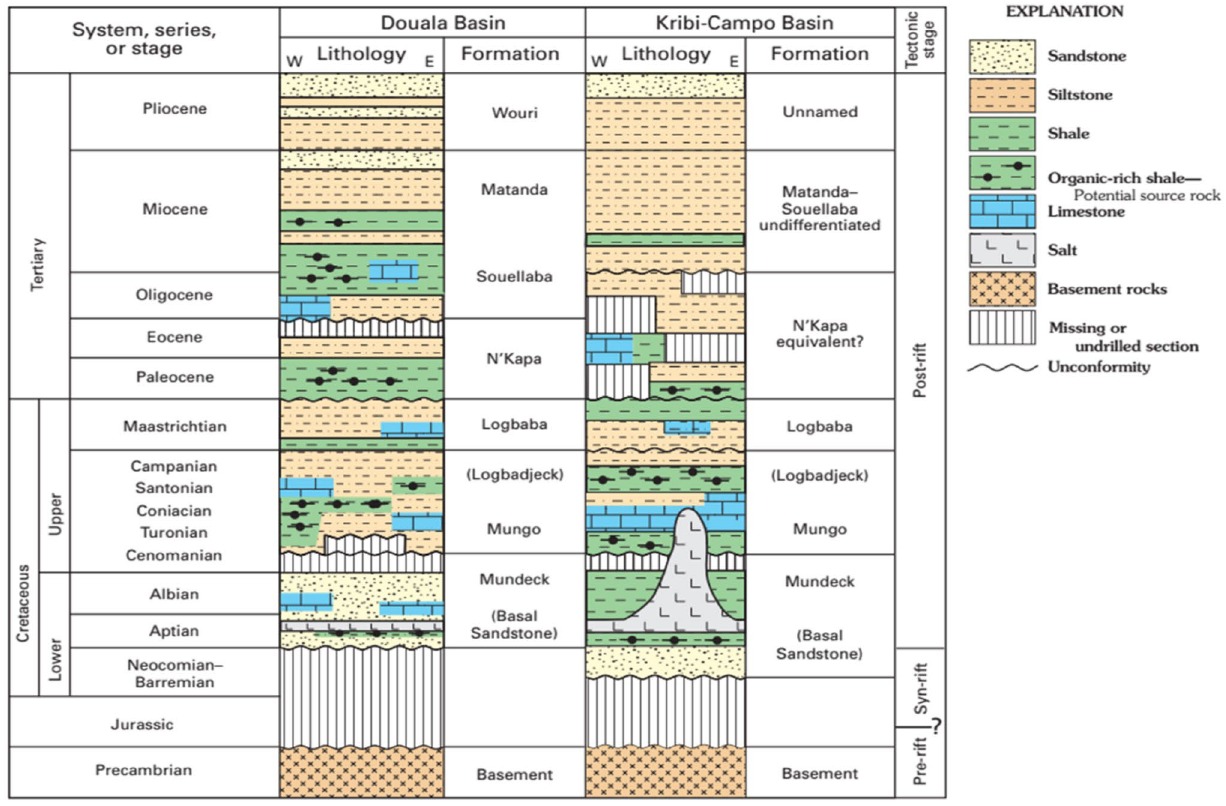
Fig. 2 The stratigraphy of the Doula Basin and Kribi-Campo Basin (Brownfield and Charpentier